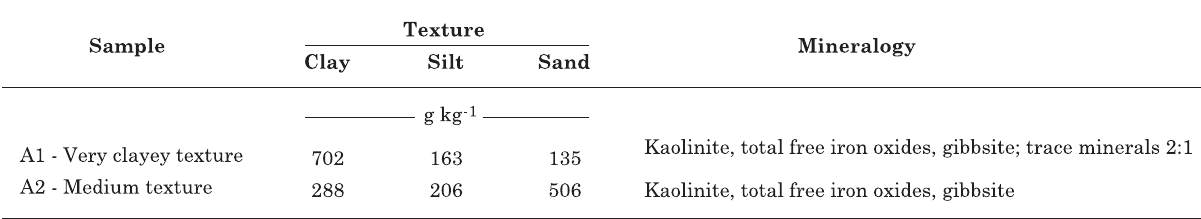
Table 1. Texture and mineralogy of the clay fraction (< 2 mm) of samples (A1) and (A2) collected under native forest, in the 0–20 cm